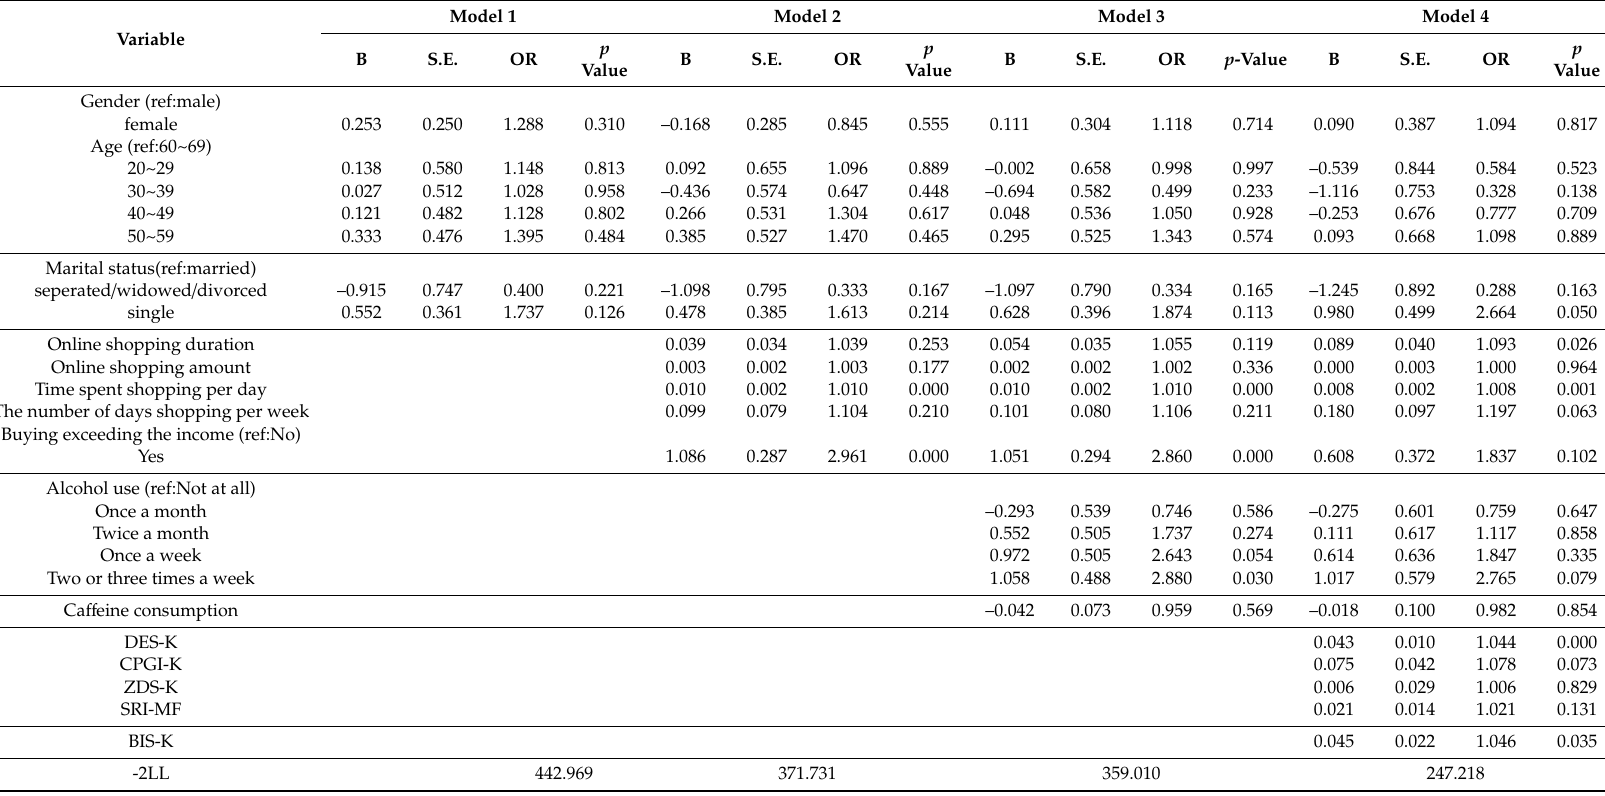
Table 5. Contributing factors to RCBS-K identified in the multiple logistic